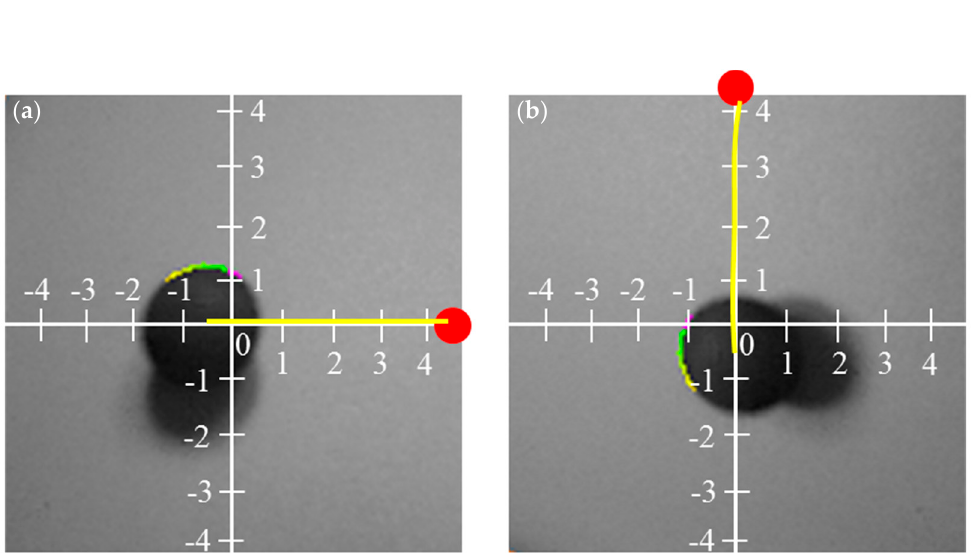
Figure 30. Markings indicating the movement of the sphere to the end point by ( a ) horizontal movement and ( b ) vertical movement by means of the optical flow method.